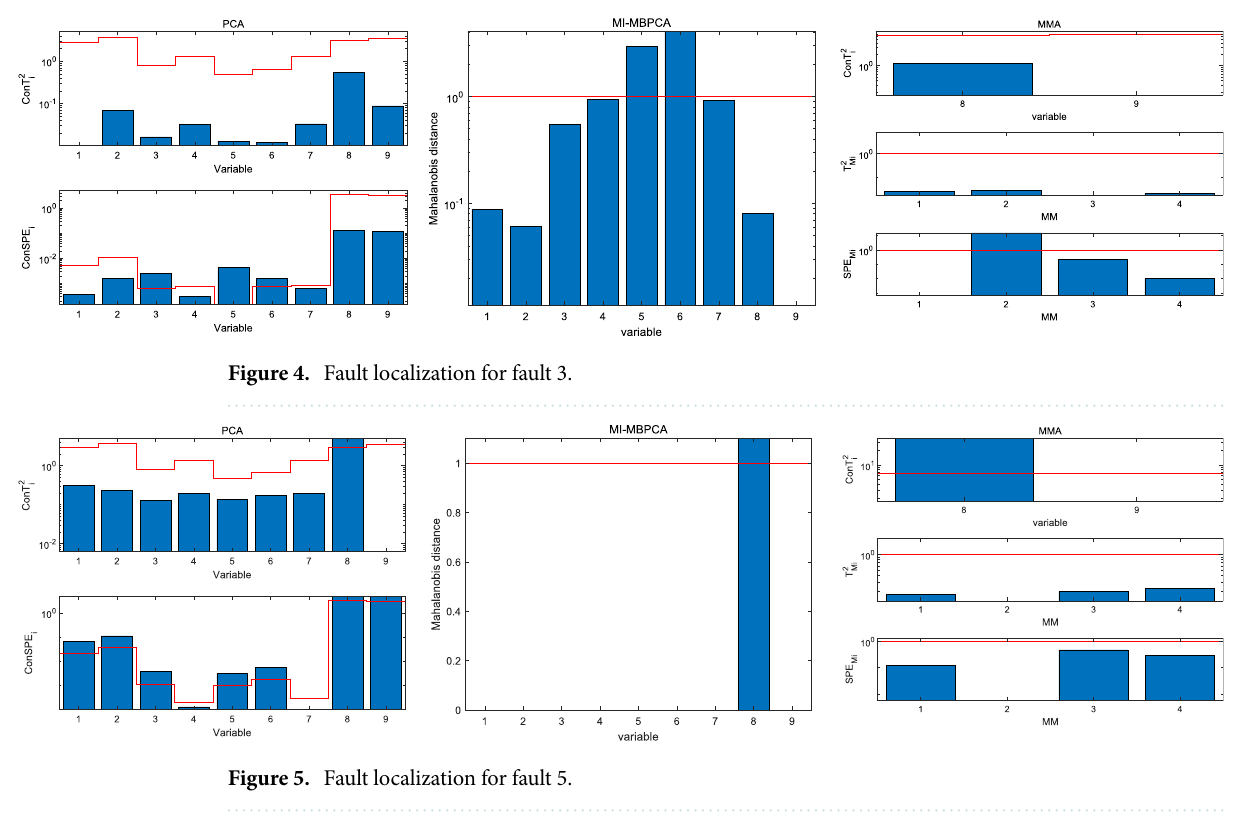
Figure 5. Fault localization for fault